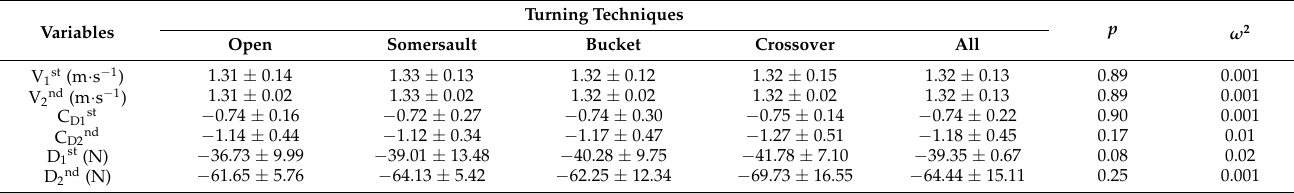
Table 2. Mean ± SD of the hydrodynamic characteristics of the first and second glidings in the four studied backstroke-to- breaststroke turning techniques.